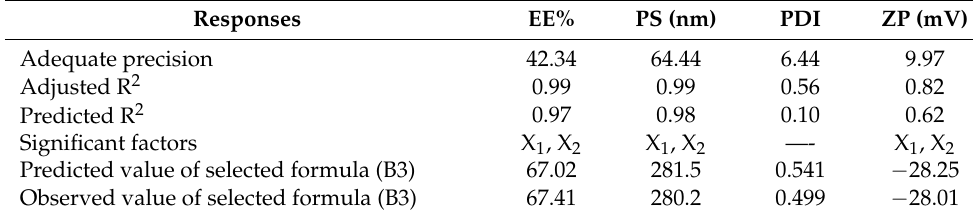
Table 2. Output data of the two full factorial designs (3 2 ) analysis of BEO-NPs formulations and predicted and observed values for the selected formula